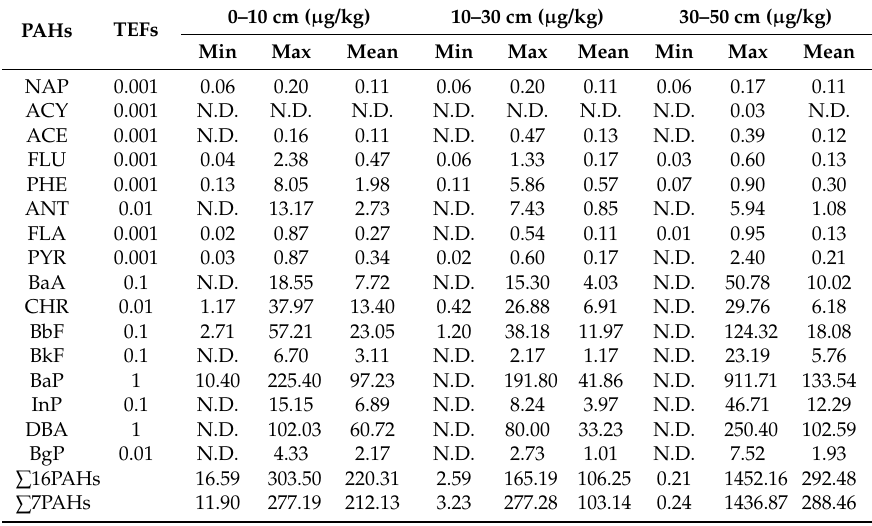
Table 6. Toxic equivalence quantities (TEQs) of PAHs in petroleum-contaminated soils ( µ g/kg).